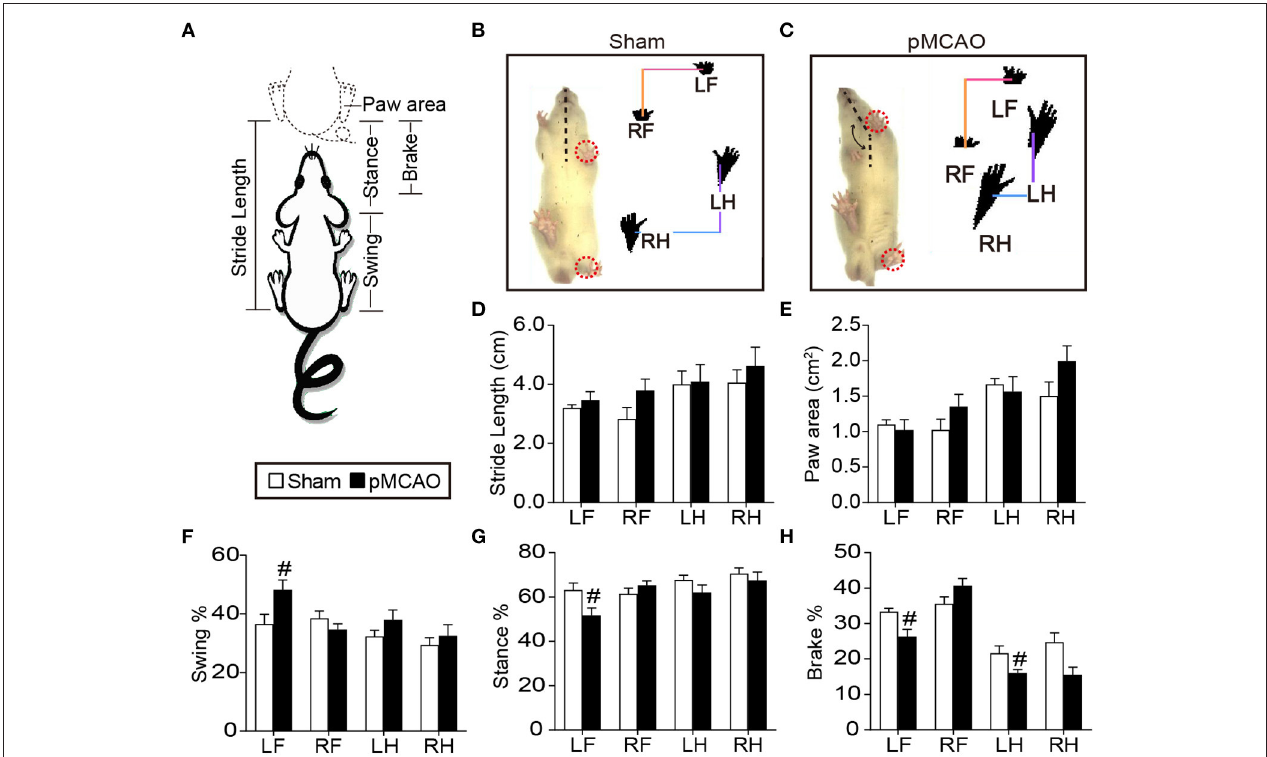
FIGURE 1 | pMCAO induced motor dysfunction in rats. (A) Schematic diagram of gait parameters including the stride length, paw area, swing time, stance time, and brake time. (B,C) Typical gait pictures captured from sham and pMCAO group. (D–H ) Quantitative analysis of the stride length, paw area, swing time, stance time, and brake time, respectively (Student’s t -test, N = 8 for the sham group and N = 9 for the pMCAO group). # P < 0.05, vs. sham